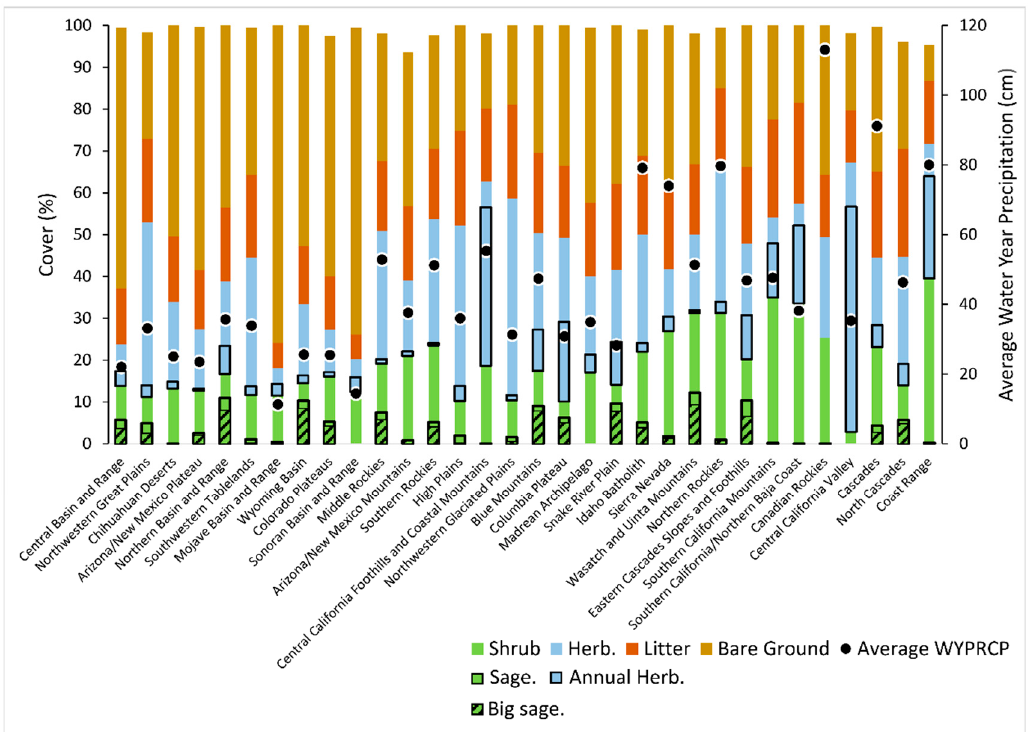
Figure 6. U.S. Environmental Protection Agency (EPA) level III ecoregion average component cover. Color corresponds to the primary components of shrub, herbaceous, litter, and bare ground. Sagebrush and annual herbaceous cover are nested (i.e., secondary) to shrub cover and herbaceous cover, respectively, shown as boxes within their primary component. Big sagebrush is nested within sagebrush and is shown as the hatched box within the secondary sagebrush box. Primary components plus tree cover are designed to sum to 100% Ecoregions are listed in order of decreasing mapped area from left to right. Secondary y-axis shows average water year precipitation (WYPRCP) within the mapped portion of the ecoregion, indicated by black points. See Figure S1 for locations of level III ecoregions.